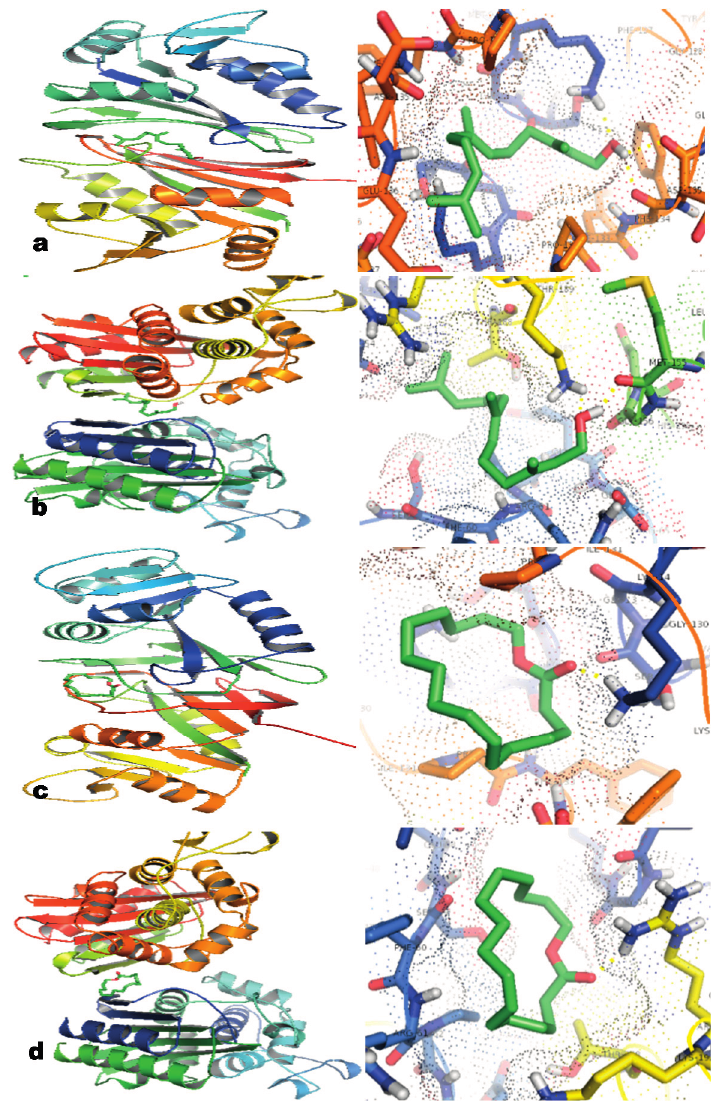
Figure 2. Putative binding pose of ligands docked with DHFR and TEM-72. The yellow dotted line indicates the H-bonding between the ligand and protein. ( a ) Molecular interaction of ligand farnesol acetate with DHFR. ( b ) Molecular interaction of ligand farnesol acetate with TEM-72. ( c ) Molecular interaction of ligand ambrettolide with DHFR. ( d ) Molecular interaction of ligand of ambrettolide with